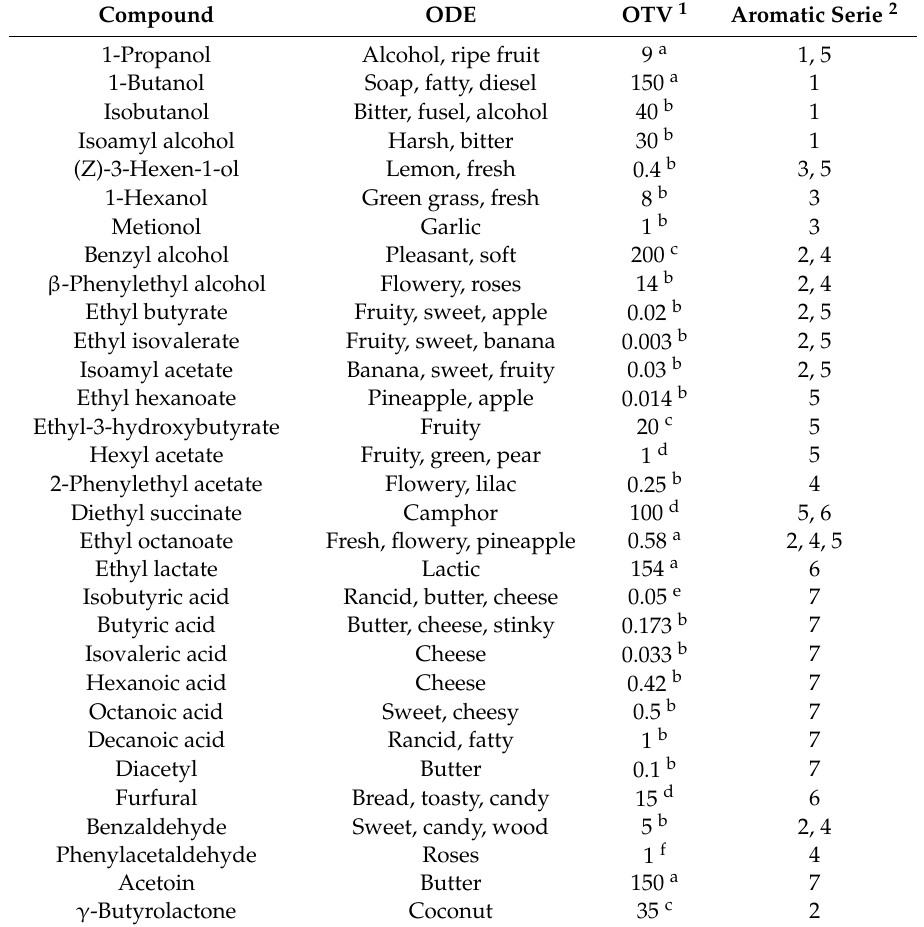
Table 1. Major aroma compounds quantified in wines. Odor description (ODE), Odor threshold value (OTV) (in mg / L), and assignation of compounds to di ff erent aromatic